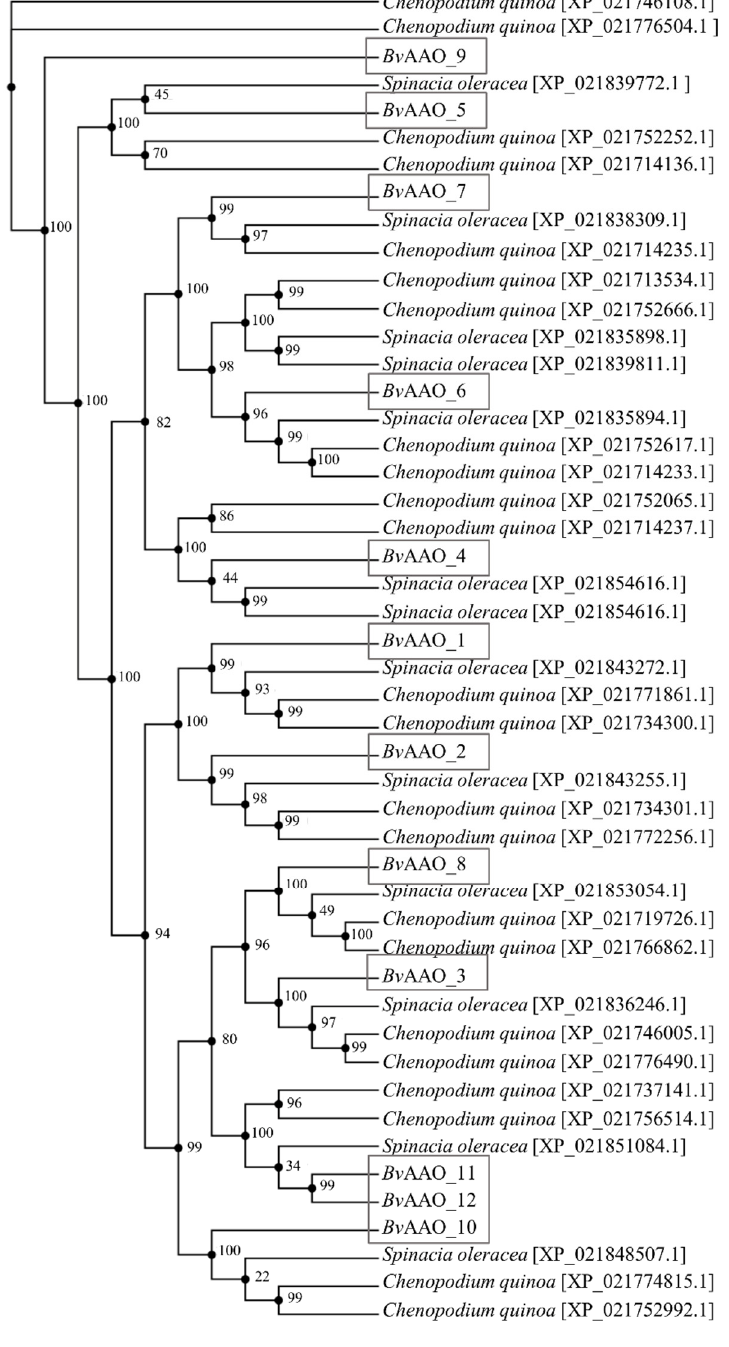
Figure 3. Phylogenetic analysis of AAO genes. Trees were built using amino acid sequences from Beta vulgaris, Spinacia oleracea and Chenopodium quinoa. The linear phylogram was constructed using the neighbor − joining method and bootstrapped 1000 times. Beet AAO genes are marked with gray